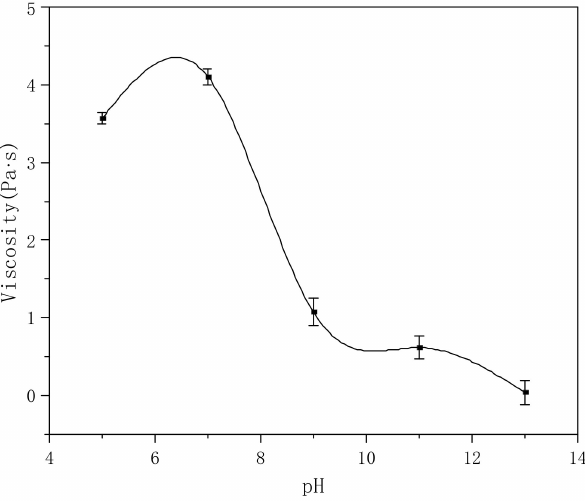
Figure 9. Effect of pH value on viscosity (polymer concentration: